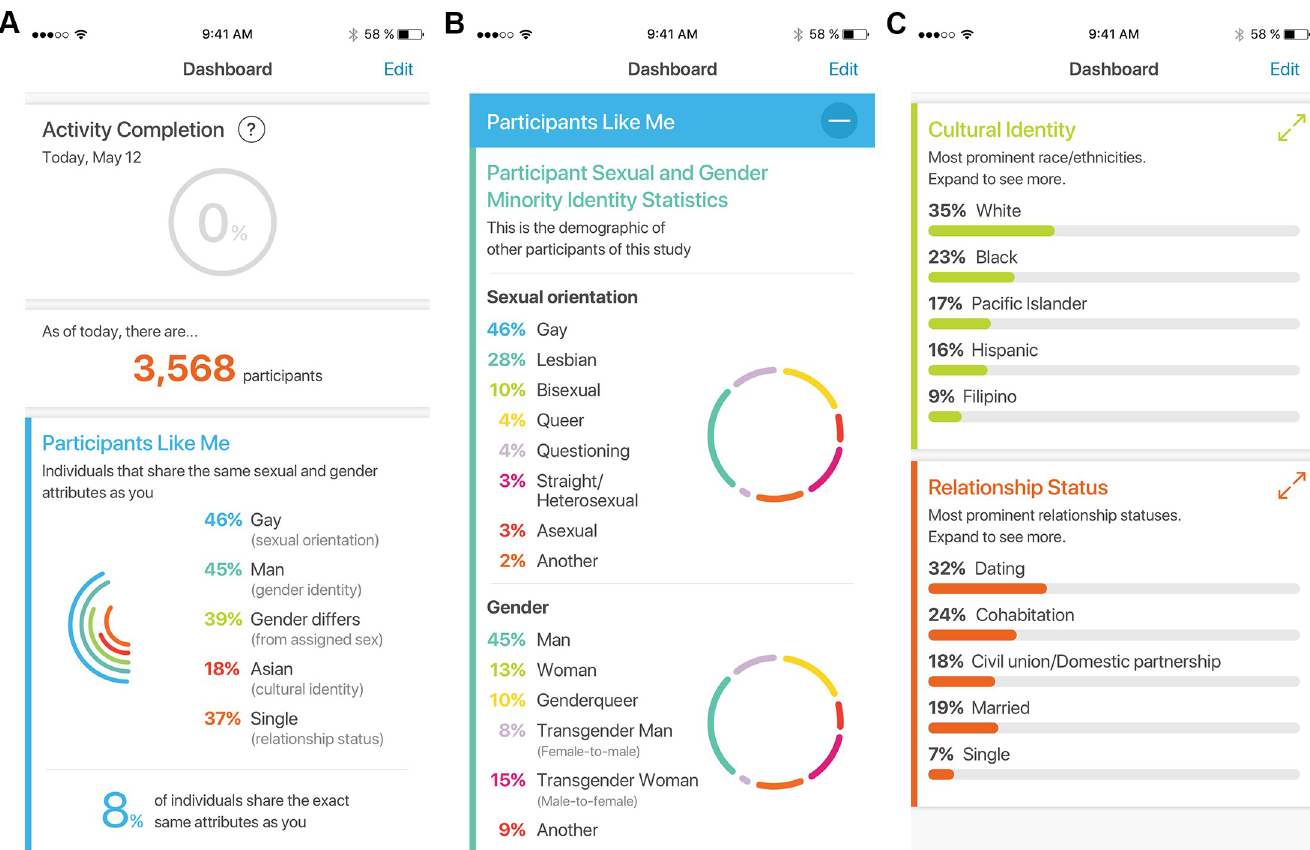
Fig 5. The PRIDE study iPhone app: Real-time dashboards. (A) Overall enrolled participant count and distribution of participants with similar demographics. (B) Distribution of participants’ sexual orientations and gender identities. (C) Distribution of participants’ racial/ethnic identities and relationship statuses.